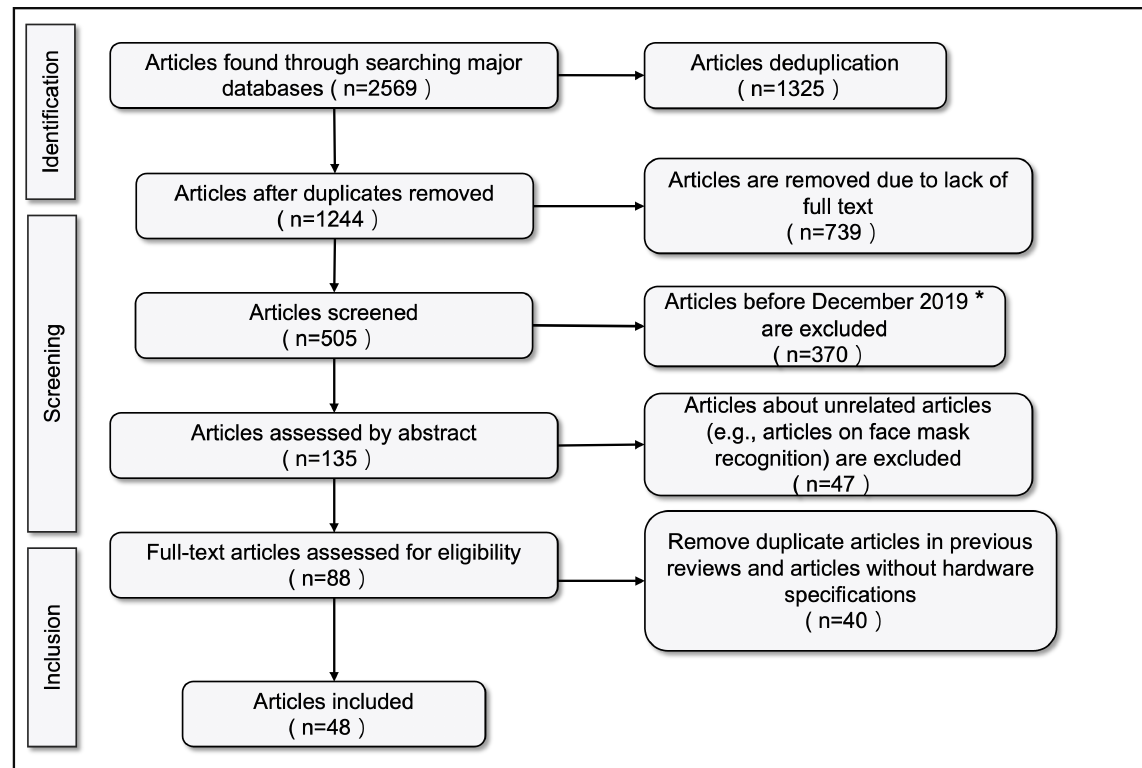
Figure 1. PRISMA diagram for two-class mask-face detection, three-class detection and mask-face hardware systems. * December 2019 refers to the time of the COVID-19